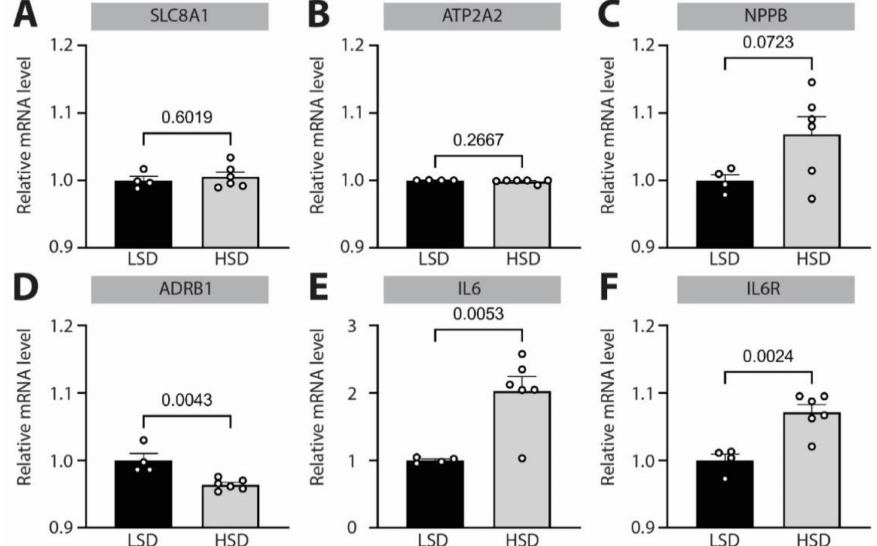
Figure 5. Effects of hypertension on the expression of disease-relevant mRNAs in Dahl salt- sensitive rats. Dahl salt-sensitive rats were kept on low-salt diet (LSD) or high-salt diet (HSD) for 10 weeks to induce hypertension. mRNA levels of ( A ) SLC8A1 (gene encoding for NCX), ( B ) ATP2A2 (gene encoding for Serca2a), ( C ) brain natriuretic peptide (NPPB), ( D ) β -adrenergic receptor 1 ( ADRB1 ), ( E ) interleukin-6 ( IL6 ) and ( F ) interleukin-6 receptor ( IL6R ) were quantified by microarray analysis and normalized to the mean expression level of LSD. Data are shown as mean ± SEM ( N = 5/6 rats for LSD/HSD). Indicated p -values were calculated using unpaired t -test (except for B, where a Mann–Whitney test was